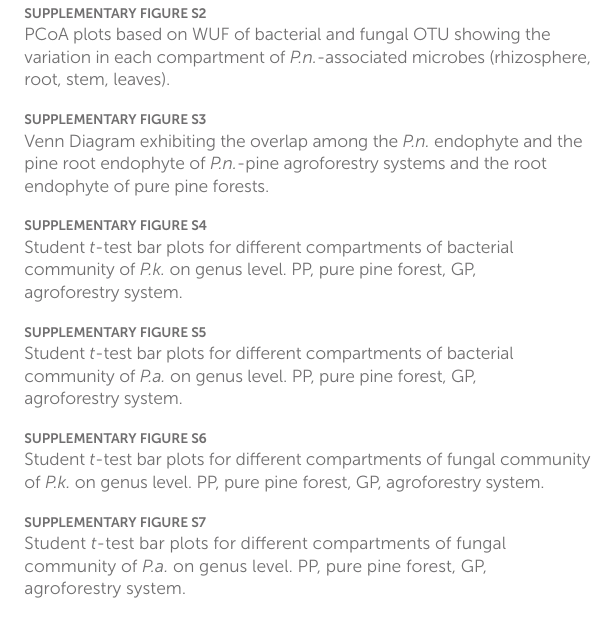
SUPPLEMENTARY TABLE S3 Pearson correlations (r value) between bacterial and fungal ɑ diversity of pine-associated microbes (Shannon, Chao 1, Shannoneven) and plant and soil variables among different compartments (bulk, rhizosphere soil and roots of pine trees). Significant effects ( p <0.05) are shown in bold. Abbreviations: F-sha, shannon index of fungi; F-Chao1, Chao1 of fungi; F-even, shannoneven index of fungi; B-sha, shannon index of bacteria; B-Chao1, Chao1 of bacteria; B-even, shannoneven index of bacteria; STK, soil total potassium; STN, soil total nitrogen; STP, soil phosphorous; NH 4+ -N, soil ammonium nitrogen; NO 3- -N, soil nitrate nitrogen; SWC, soil water content; EC, soil conductivity. SUPPLEMENTARY TABLE S4 PerMANOVA (Permutational multivariate analysis) indicated the relative contributions of genotype (G), pine tree species (Ps) and their interactions on bacterial and fungal alpha diversity among different compartments (rhizosphere soils, roots, stems, leaves of P.n. ). p < 0.05, ** p < 0.01, *** p < 0.001. SUPPLEMENTARY TABLE S5 Pearson correlations (r value) between bacterial and fungal α -diversity of P.n. -associated microbes (Shannon, Chao 1, Shannoneven) and plant and soil variables. Significant effects ( p < 0.05) are shown in bold. Abbreviations of soil variables are as defined in Supplementary Table S3 . Abbreviations: F-sha, shannon index of fungi; F-Chao1, Chao1 of fungi; F-even, shannoneven index of fungi; B-sha, shannon index of bacteria; B-Chao1, Chao1 of bacteria; B-even, shannoneven index of bacteria; PWC, plant water content; P_Fw, plant fresh weight; P_Dw, plant dry weight; PTN, plant total nitrogen; PTP, plant total phosphorous. SUPPLEMENTARY TABLE S6 PerMANOVA based on WUF revealing the relative contributions of genotype (G), compartment (C) and planting P.n. or not (Pn) on bacterial and fungal variations across all samples and in each compartment of pine-associated microbes. Significant levels: p < 0.05, ** p < 0.01, *** p < 0.001. SUPPLEMENTARY TABLE S7 PerMANOVA based on WUF revealing the relative contributions of genotype (G), compartment (C) and pine tree species (Ps) on bacterial and fungal variations across all samples and in each P.n.-asscioated compartment (rhizosphere, root, stem, leaves). Significant levels: * p < 0.05, ** p < 0.01, *** p < 0.001. SUPPLEMENTARY FIGURE S1 PCoA plots based on WUF (weighted unifrac distance) of bacterial and fungal OTU showing the variation in each compartment of pine- associated microbes (root, rhizosphere, between). SUPPLEMENTARY FIGURE S2 PCoA plots based on WUF of bacterial and fungal OTU showing the variation in each compartment of P.n. -associated microbes (rhizosphere, root, stem, leaves). SUPPLEMENTARY FIGURE S3 Venn Diagram exhibiting the overlap among the P.n. endophyte and the pine root endophyte of P.n. -pine agroforestry systems and the root endophyte of pure pine forests. SUPPLEMENTARY FIGURE S4 Student t -test bar plots for different compartments of bacterial community of P.k. on genus level. PP, pure pine forest, GP, agroforestry system. SUPPLEMENTARY FIGURE S5 Student t -test bar plots for different compartments of bacterial community of P.a. on genus level. PP, pure pine forest, GP, agroforestry system. SUPPLEMENTARY FIGURE S6 Student t -test bar plots for different compartments of fungal community of P.k. on genus level. PP, pure pine forest, GP, agroforestry system. SUPPLEMENTARY FIGURE S7 Student t -test bar plots for different compartments of fungal community of P.a. on genus level. PP, pure pine forest, GP, agroforestry